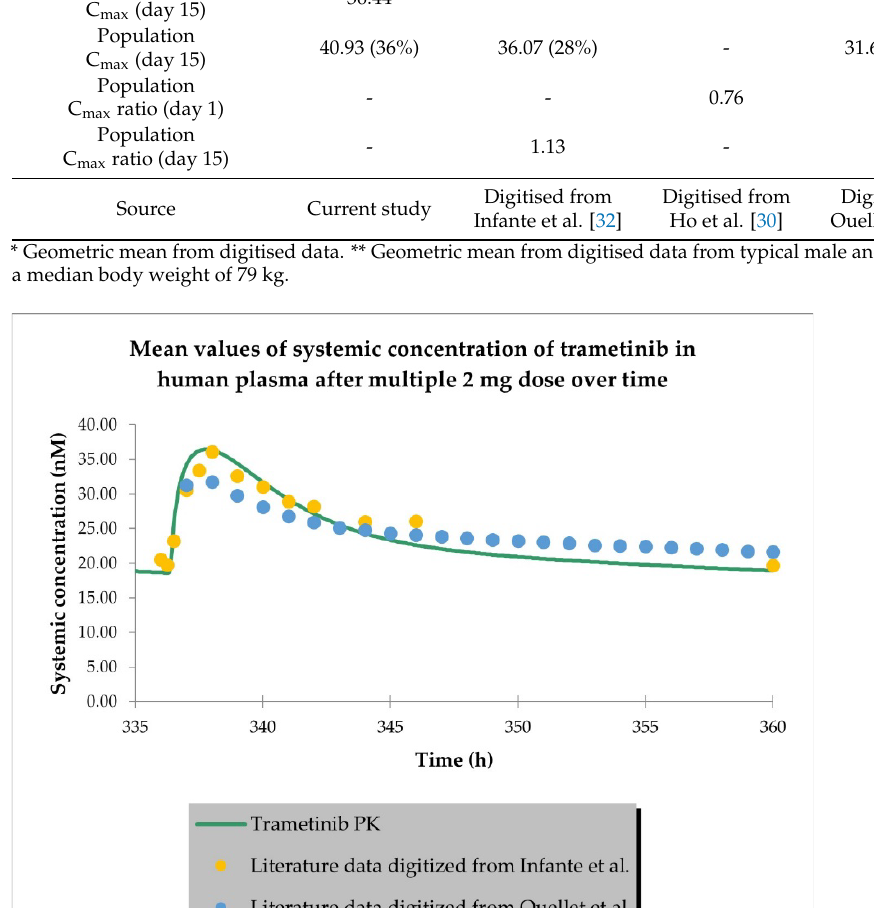
Figure 3. PBPK model of trametinib after a repeated dose in cancer patient representative. Observed data are presented as means from literature data (digitised from Infante et al. [32] and Ouellet et al. [31] as indicated in Table 3).